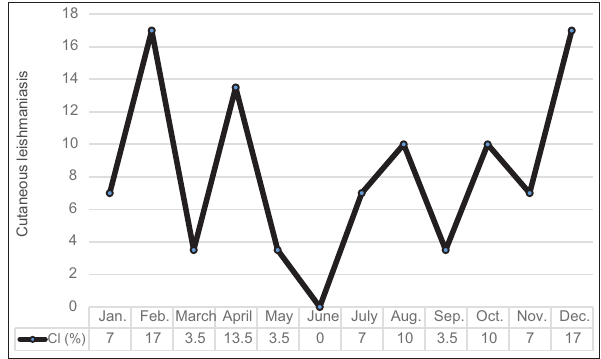
Figure-2: The monthly trend of human cutaneous leishmaniasis in Tangestan County, Bushehr Province